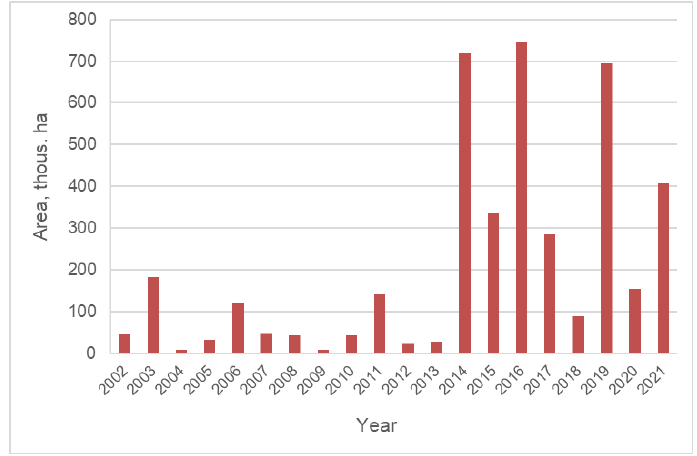
Figure 2. Dynamics of burnt forest areas within the forest complex of the Irkutsk Region from 2002 to 2021 [15,16].